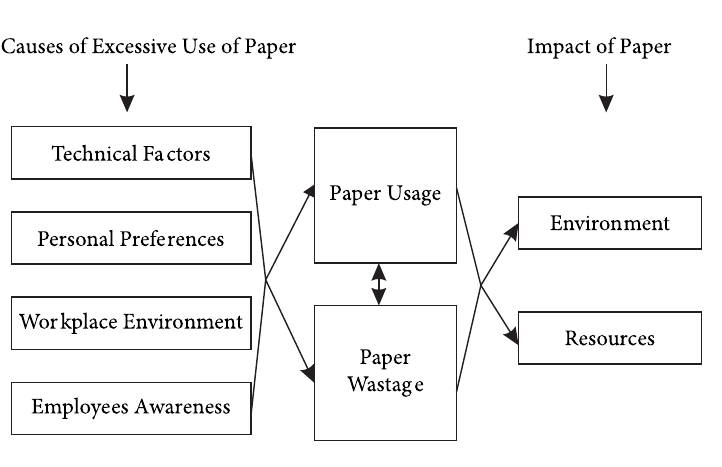
Figure 1. Conceptual